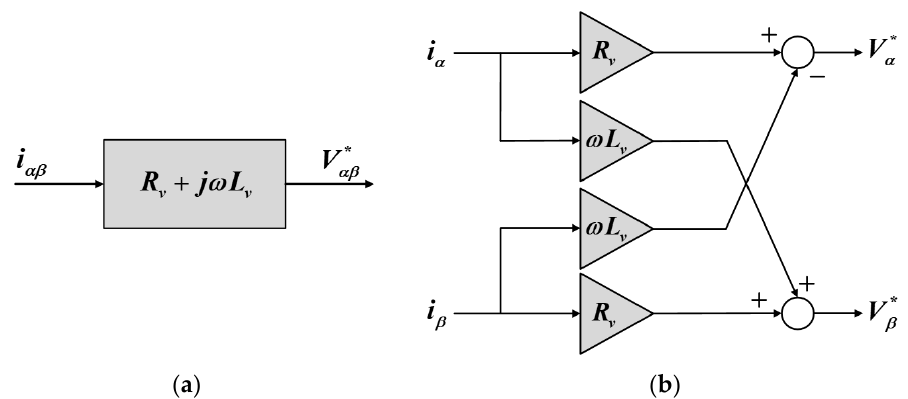
Figure 5. Derivative-less forms of a virtual impedance controller. ( a ) Algebraic approximation and ( b ) cross-coupling feedback of a current vector [32].